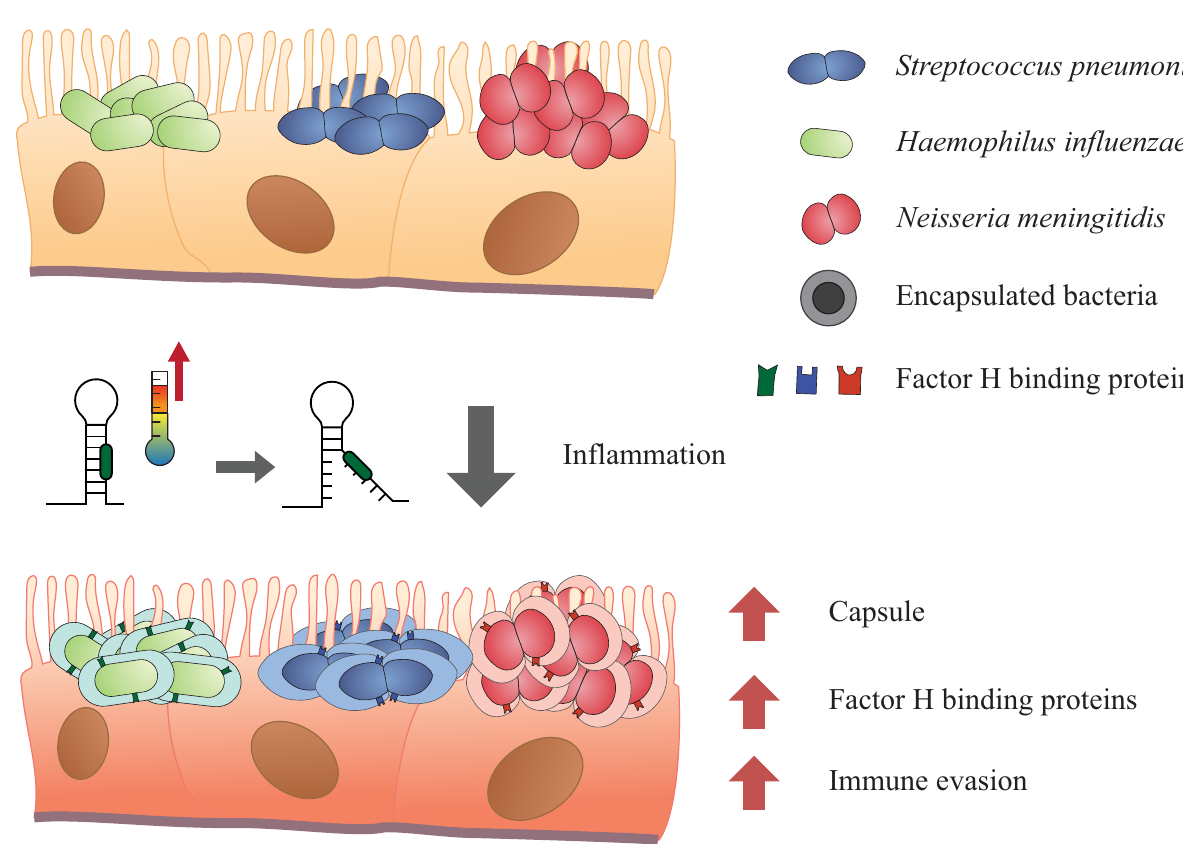
Fig 5. Model of pathogenesis, from commensalism to systemic infection. Mucosal surface inflammation (e.g. by trauma or infection) raises the temperature, leading to increased expression of virulence determinants such as polysaccharide capsules and FH binding proteins of S . pneumoniae , H . influenzae and N . meningitidis . This thermoregulation enables the bacteria to evade immune responses on the mucosal surfaces. The bacteria are primed to higher temperature and might have a better chance of surviving within the body, possibly increasing the rate of systemic infections. Green box in RNA structure denotes ribosome binding site. Model not according to